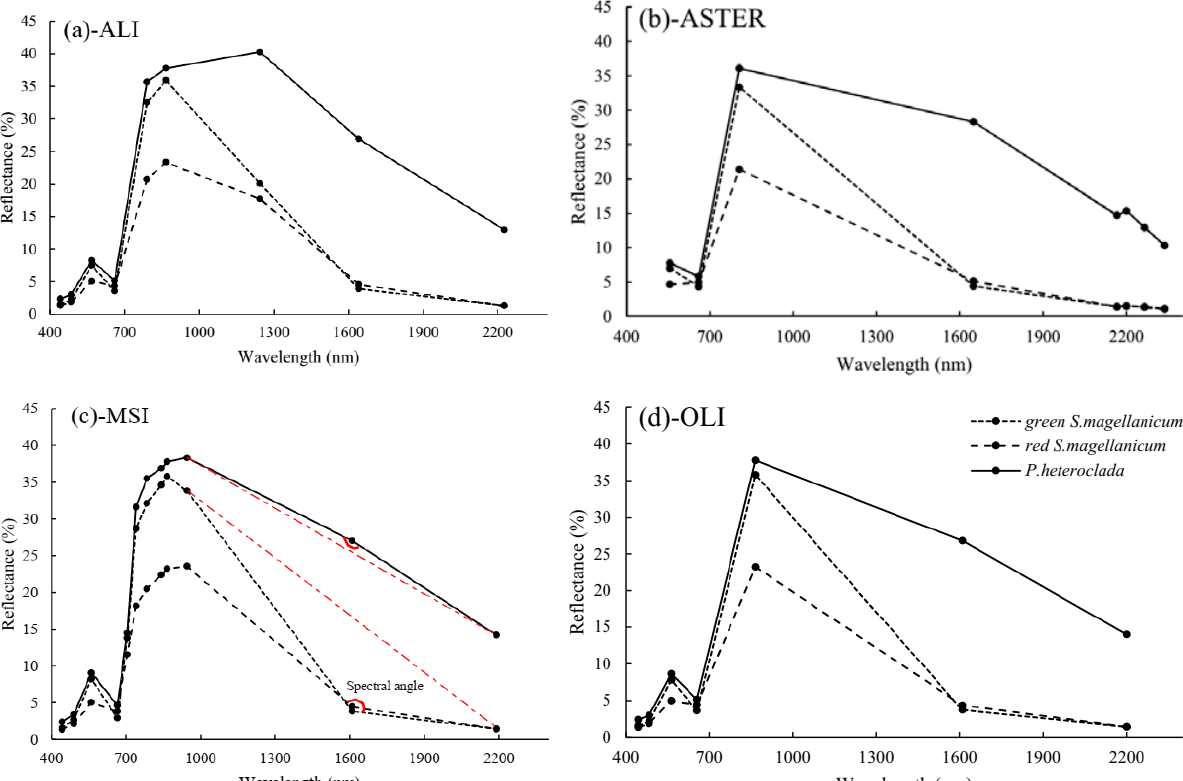
Figure 13. Equivalent sensor spectral curves of P. heteroclada and S. magellanicum